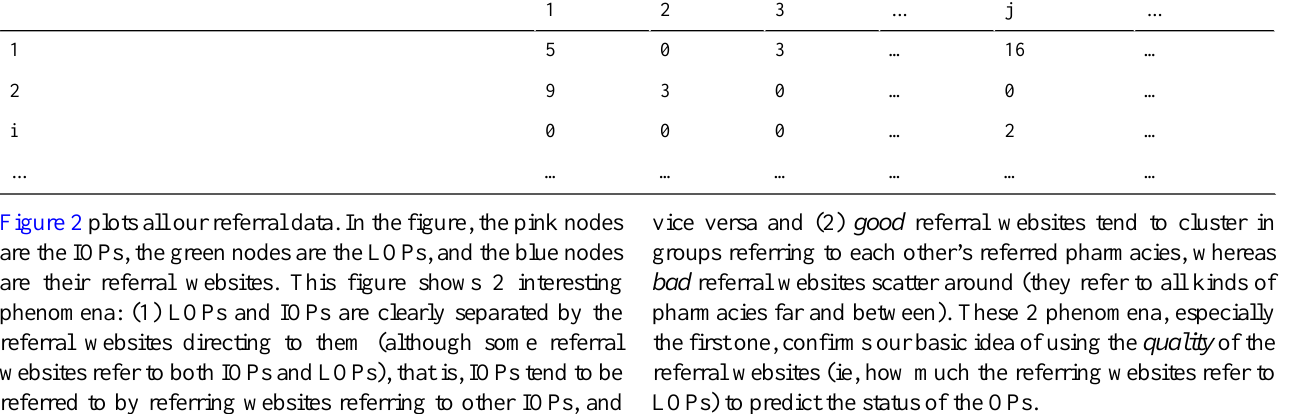
Referral site, jPharmacy site, i